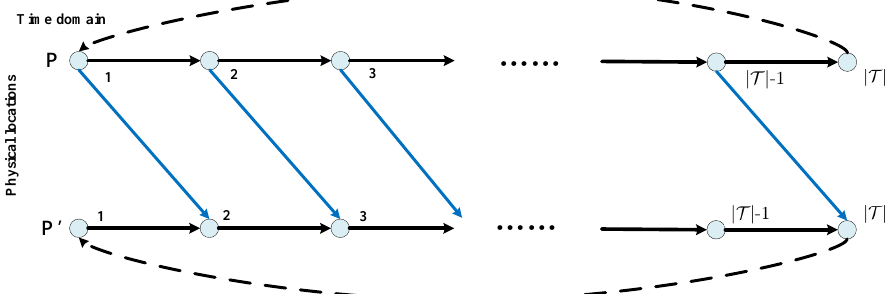
Figure 2. Time-space